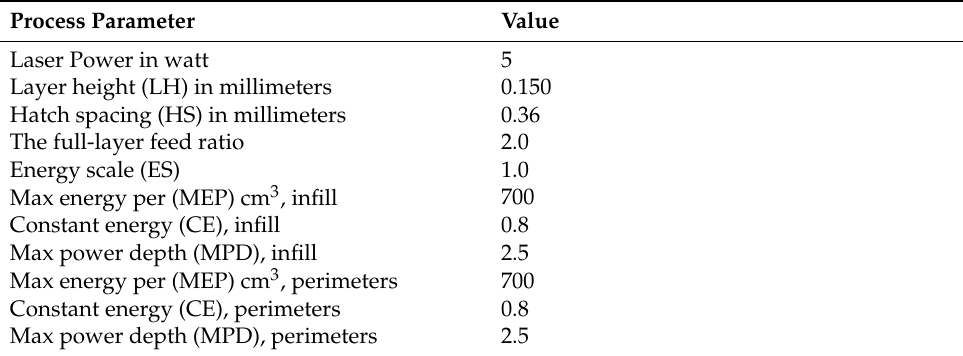
Table 1. SLS process parameters for PPP/CF thermoset powder.